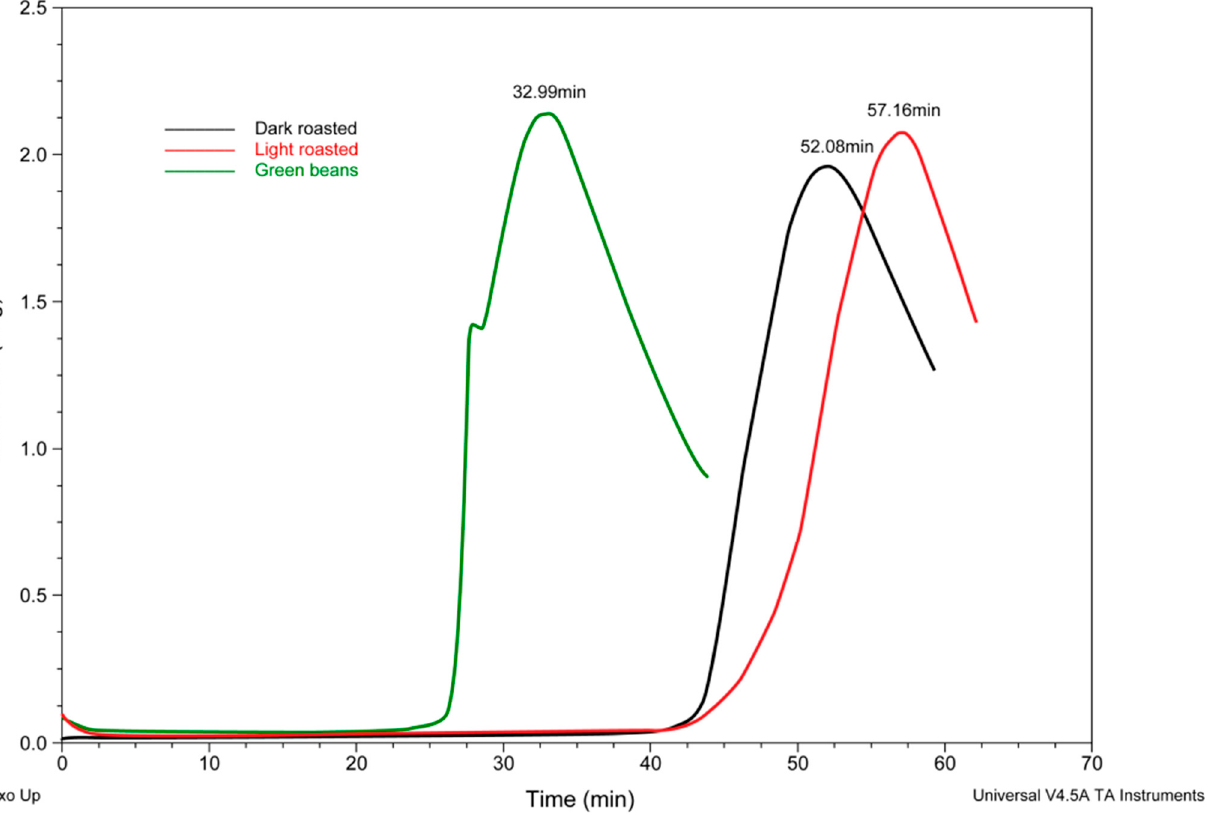
Figure 2. The oxidation induction time of Brazilian coffee samples.